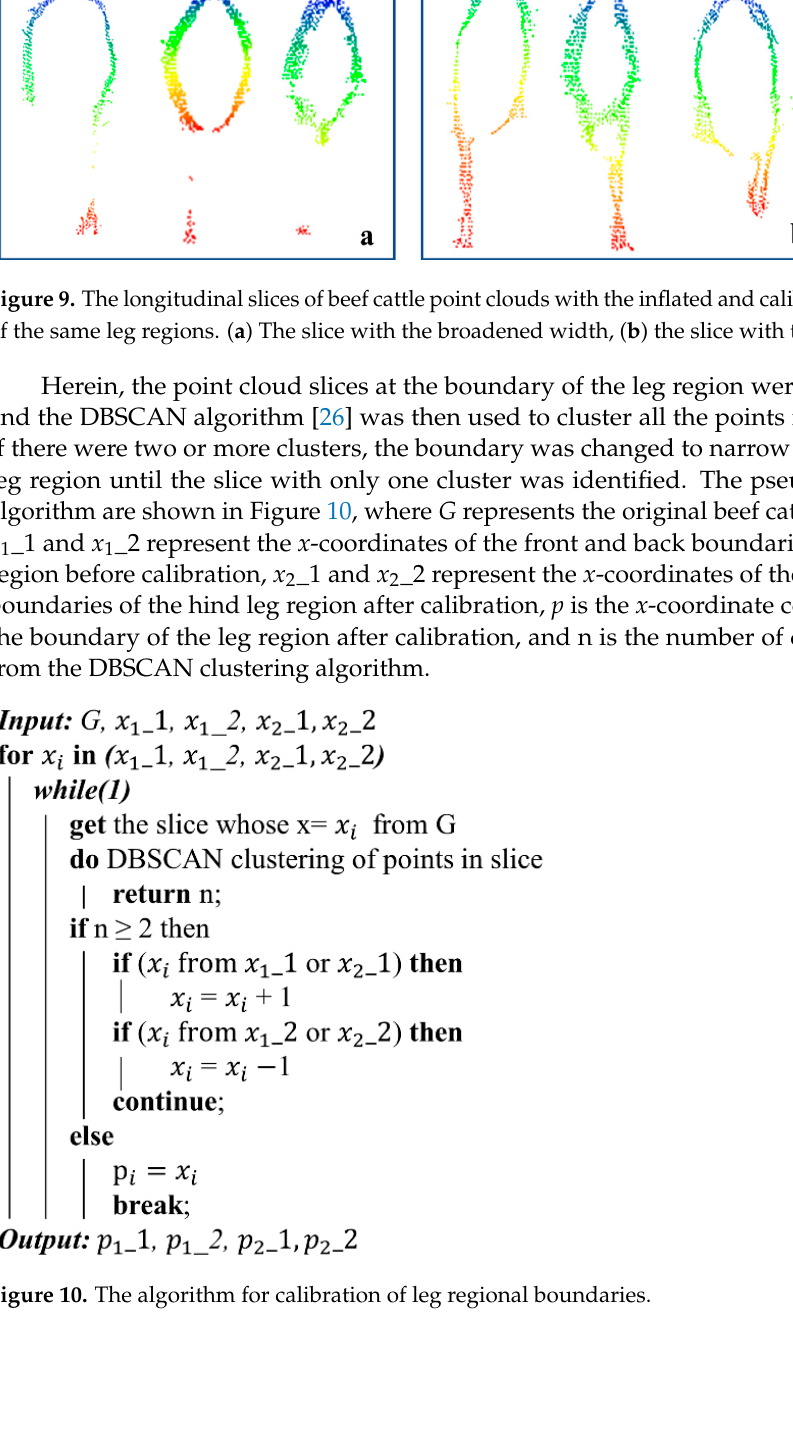
Figure 10. The algorithm for calibration of leg regional boundaries.